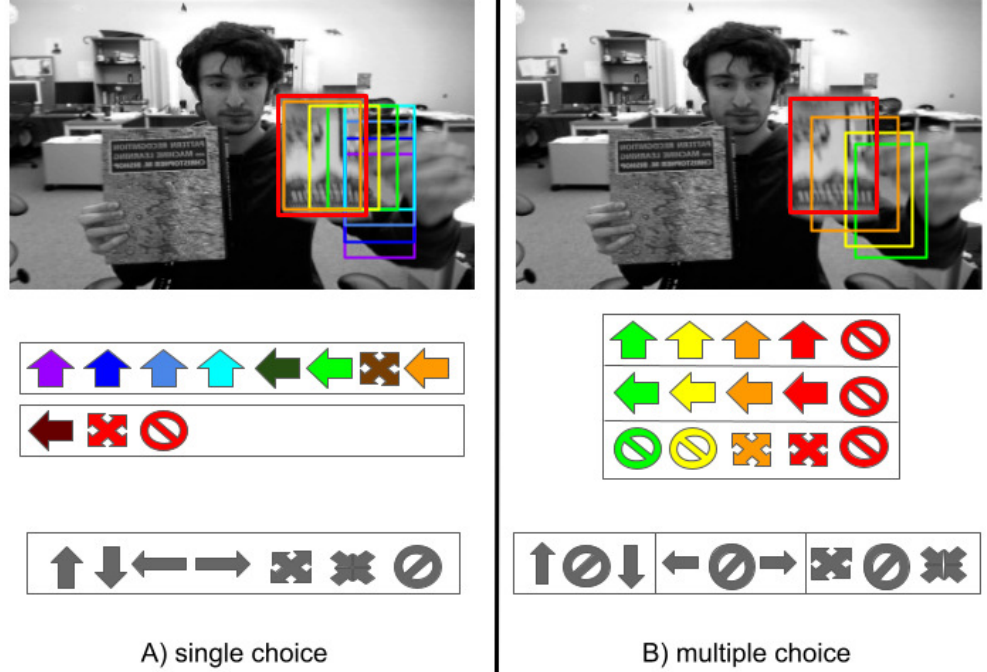
Figure 1. ( A ) In iterative single refinement, starting from an initial bounding box, a sequence of transformations to the bounding box is predicted and applied to locate the target. ( B ) With multiple refinements, a sequence of multiple non-conflicting transformations is predicted and